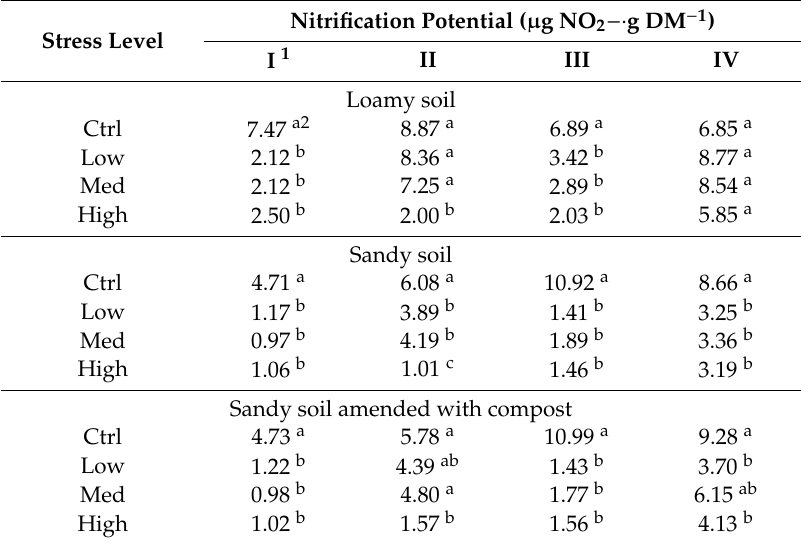
Table 2. Nitrification potential as dependent on water stress and sampling